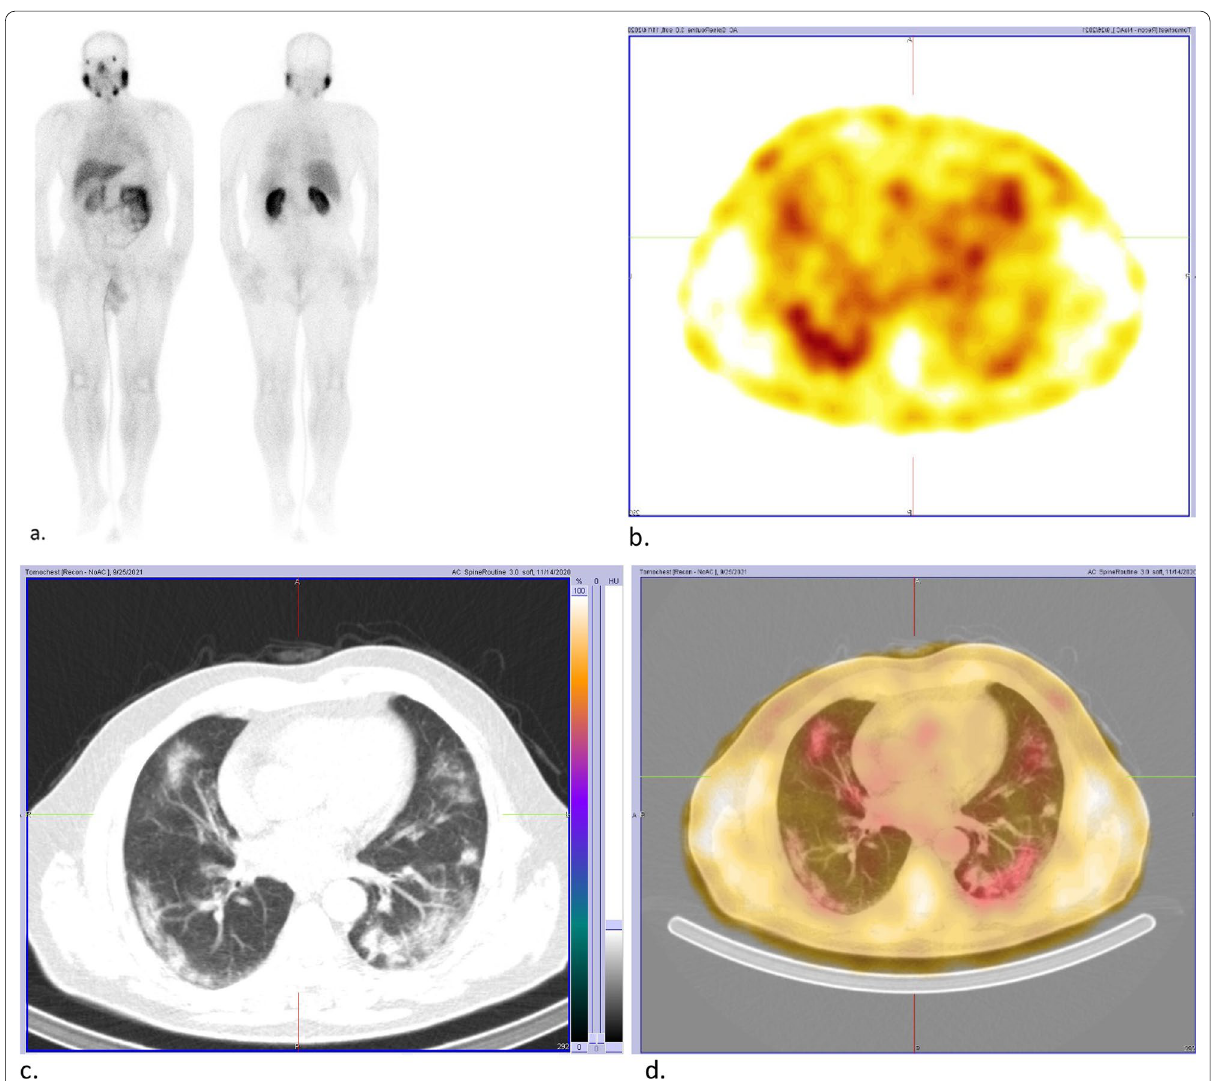
Fig. 1 a Whole-body 99mTc-PSMA study with faint uptake in the chest region as well as physiologic distribution of radiotracer. b SPECT reveals mild peripheral 99mTC-PSMA uptake in the lung fields. c CT shows multifocal, bilateral and peripheral ground-glass opacities in lungs. d Fused SPECT/CT shows the PSMA uptake is matched by ground-glass opacities in the lung (left lung COVID-related consolidation also shows the same uptake just it is not apparent in this cut due to respiratory motion